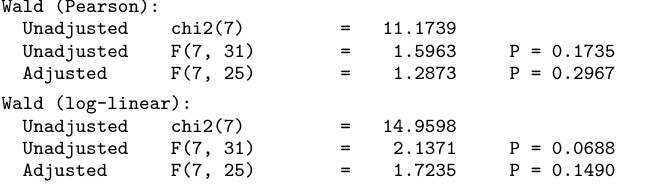
164 svy: tabulate twoway — Two-way tables for survey